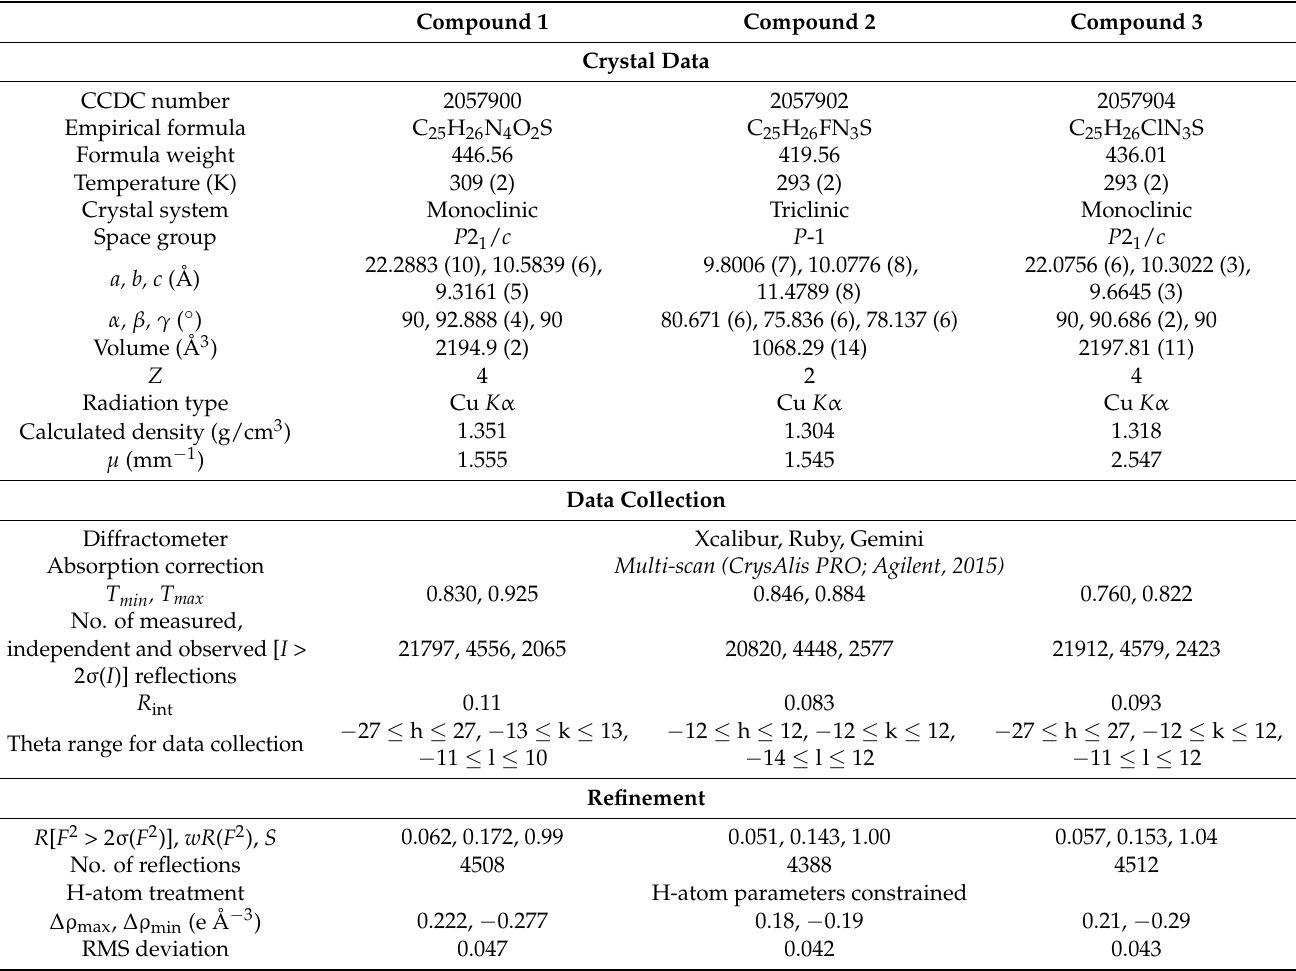
Table 1. Crystallographic data and structure refinement parameters of compounds 1 , 2 and 3 . Compound 1 Compound 2 Compound 3 Crystal Data